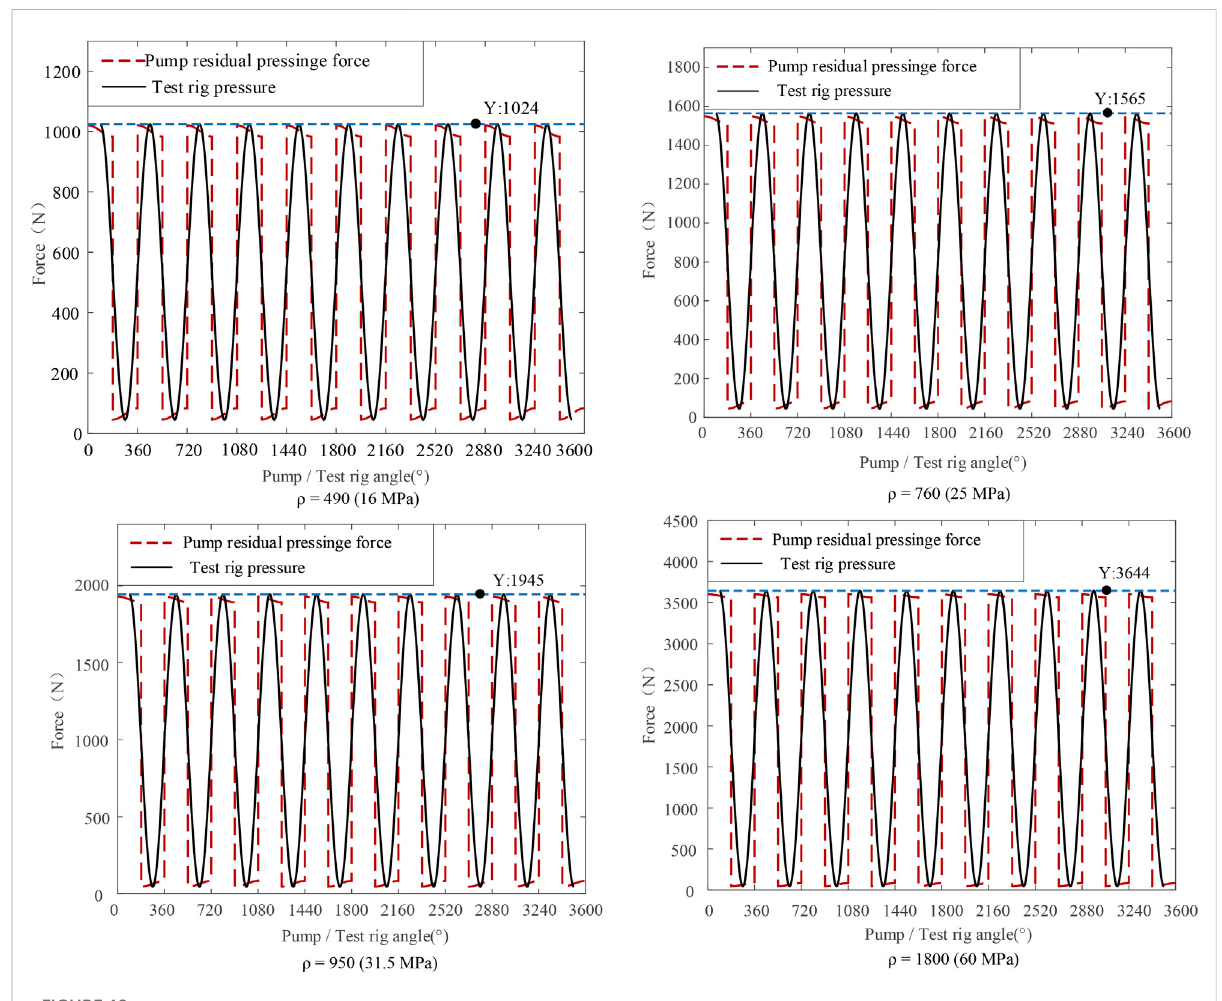
FIGURE 12 Fitted diagram of pump and test set compression force.